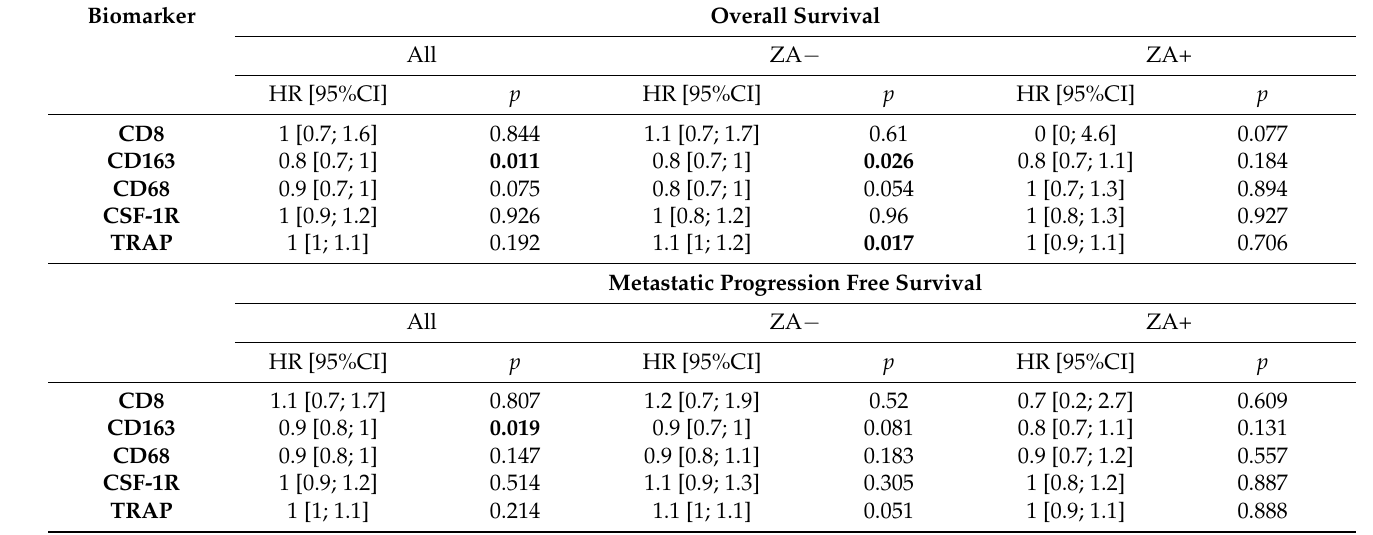
Table 3. Univariable analyses of biomarkers associated with overall survival and metastatic progression-free survival and exploratory subgroup analyses according to the treatment ( n =